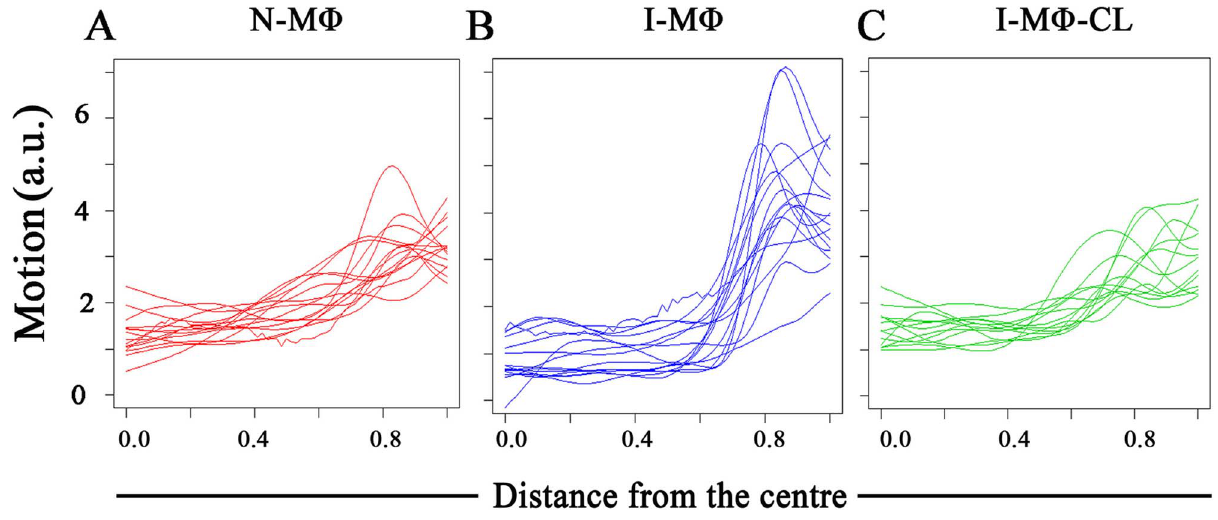
Figure 4. Analysis of PLC d 1 movement. RAW264.7 cells were transfected with plc d 1-gfp plasmid. Average motions of the PLC d 1-GFP were measured by computational analysis as a function of distance from center of cell. Each line represents a particular cell. Motion is on a scale of 0–6 (arbitary unit, a.u.). A) N-M W ; B) I-M W ; and C) I-M W -CL.